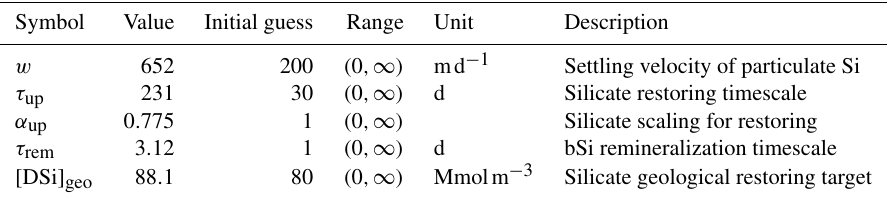
Table A1. Optimized Si cycling model